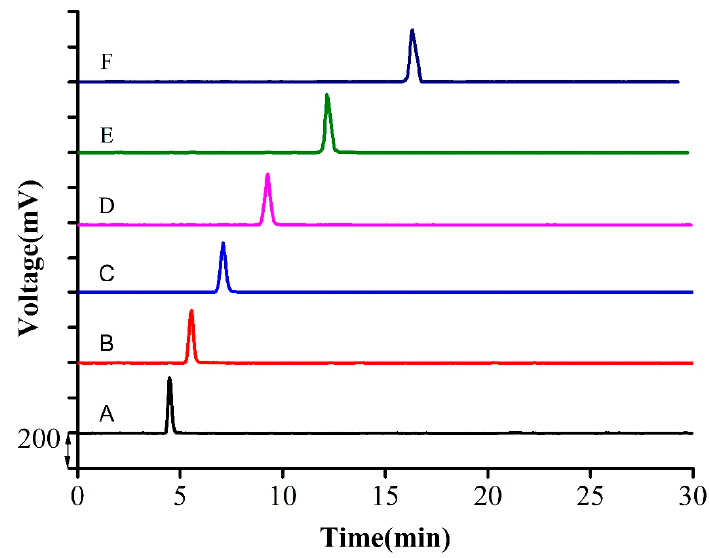
Figure 5. High liquid chromatograms of purified products.